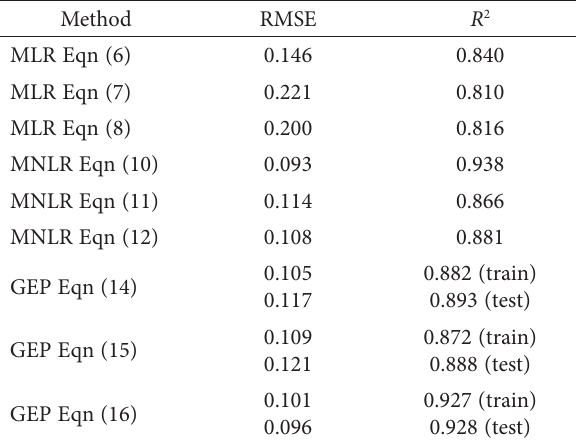
Table 3. Statistical performance of GEP and regression models (MLR/MNLR)